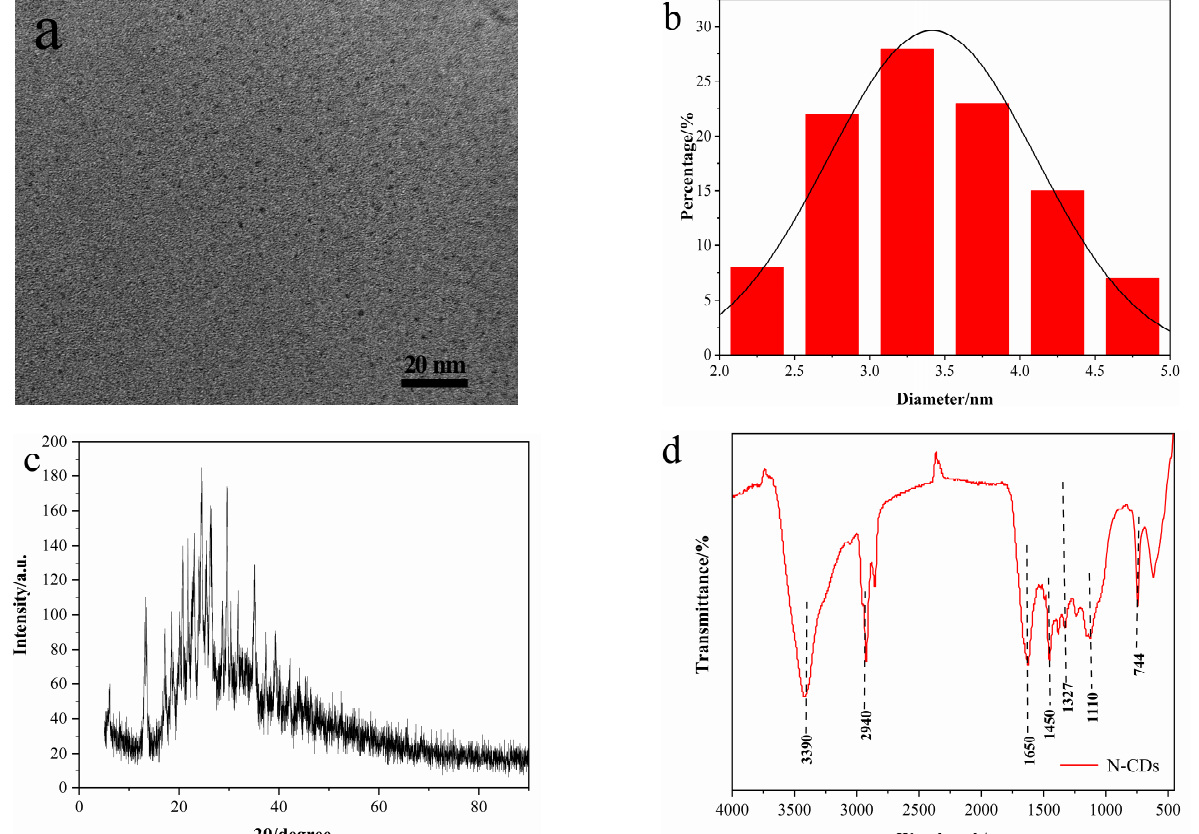
Figure 2. ( a ) HRTEM image of N-CDs; ( b ) particle size distribution of N-CDs; ( c ) XRD pattern of N-CDs; ( d ) FTIR spectrum of N-CDs.